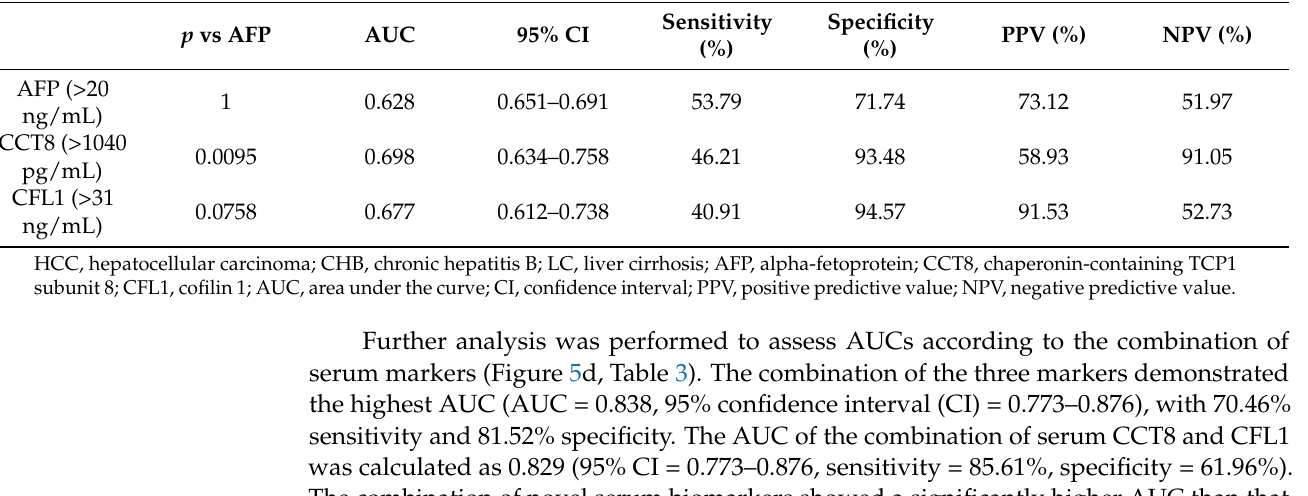
Table 2. Diagnostic efficiency of serum exosomal protein markers and AFP in HCC diagnosis. HCC vs. Non-Tumor (Normal, CHB, and LC)